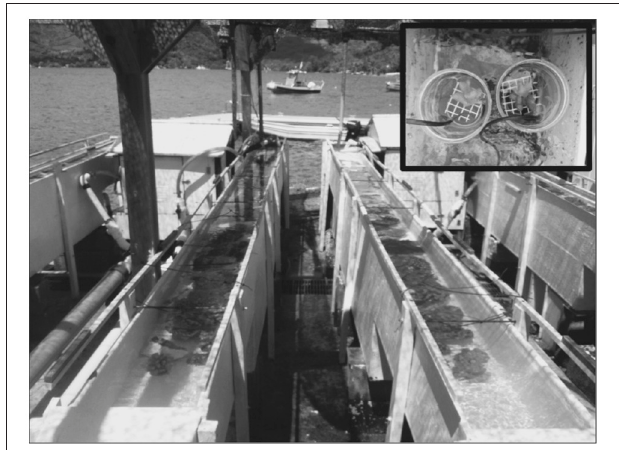
FIGURE 2 | Picture of flumes with experimental coral reef communities 1 and 2 in place. Covers with blue filters are not in place so as to show coral reef community within the flume. Inset shows 2-L chamber, containing a Pocillopora verrucosa colony and a small pump for seawater circulation, which were placed within the flumes at the time of